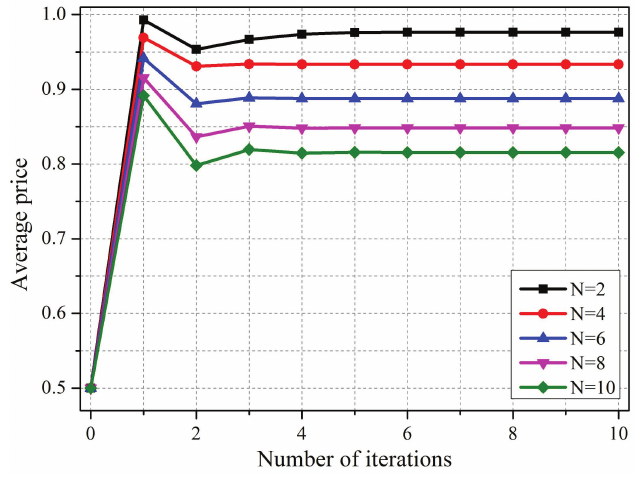
Figure 6. Convergence performance of the proposed